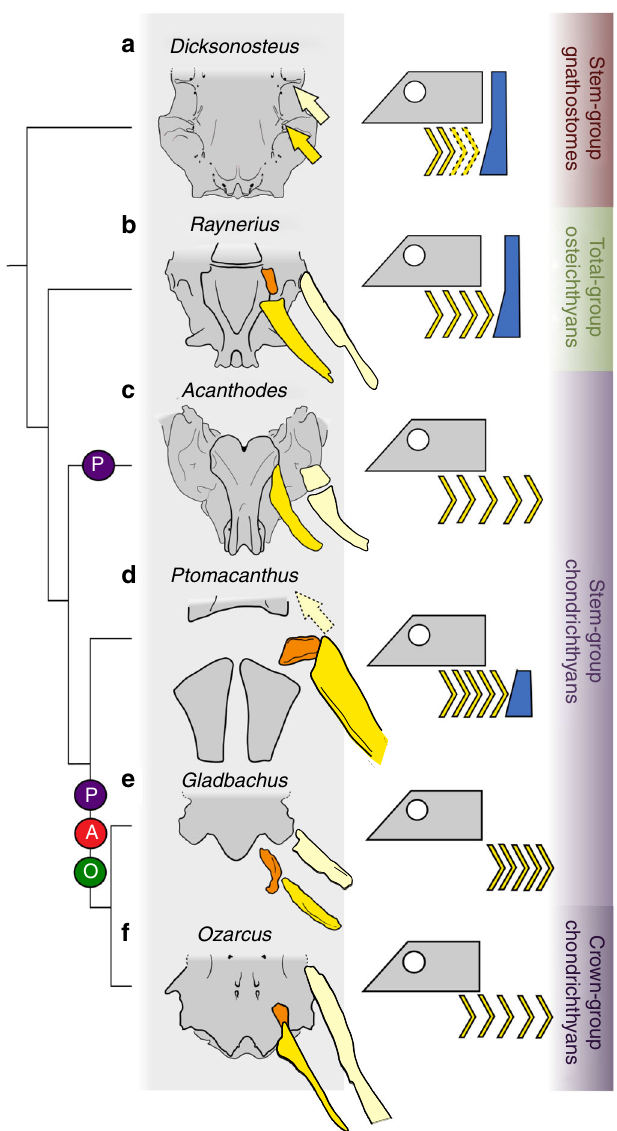
Fig. 3 Postero-anterior extent of branchial skeleton in early gnathostomes. The phylogenetic tree is congruent with the topology described in the results (Supplementary Figs. 4, 5). Changes in position are reconstructed: P indicates a shift of the posterior extent of the branchial skeleton, A indicates a shift of the anterior extent, O indicates the appearance or loss of a bony operculum. Colour scheme: grey, neurocranium; pale yellow, hyomandibular; bright yellow, epibranchial; orange, pharyngobranchial; blue, dermal shoulder girdle. Reconstructions redrawn from refs. 5,6,20,22,25,46 . The redrawn illustration from fi gure 8 of Maisey 46 is used with permission from the American Museum of Natural